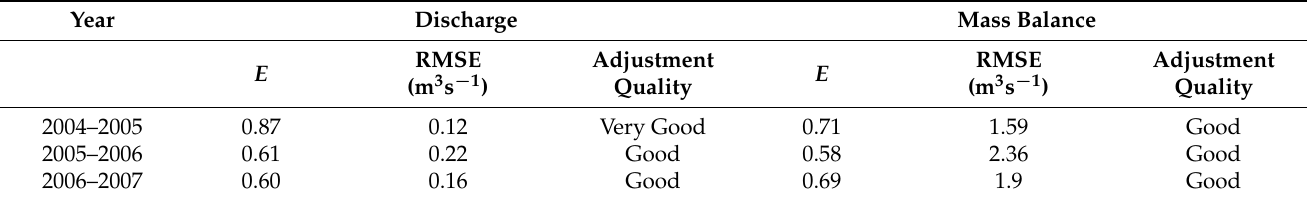
Table 3. Nash Suffcliffe coefficients ( E ) and root mean square error (RMSE) for discharge and mass balances with quality classification categories of Cabrera (2009) [42].